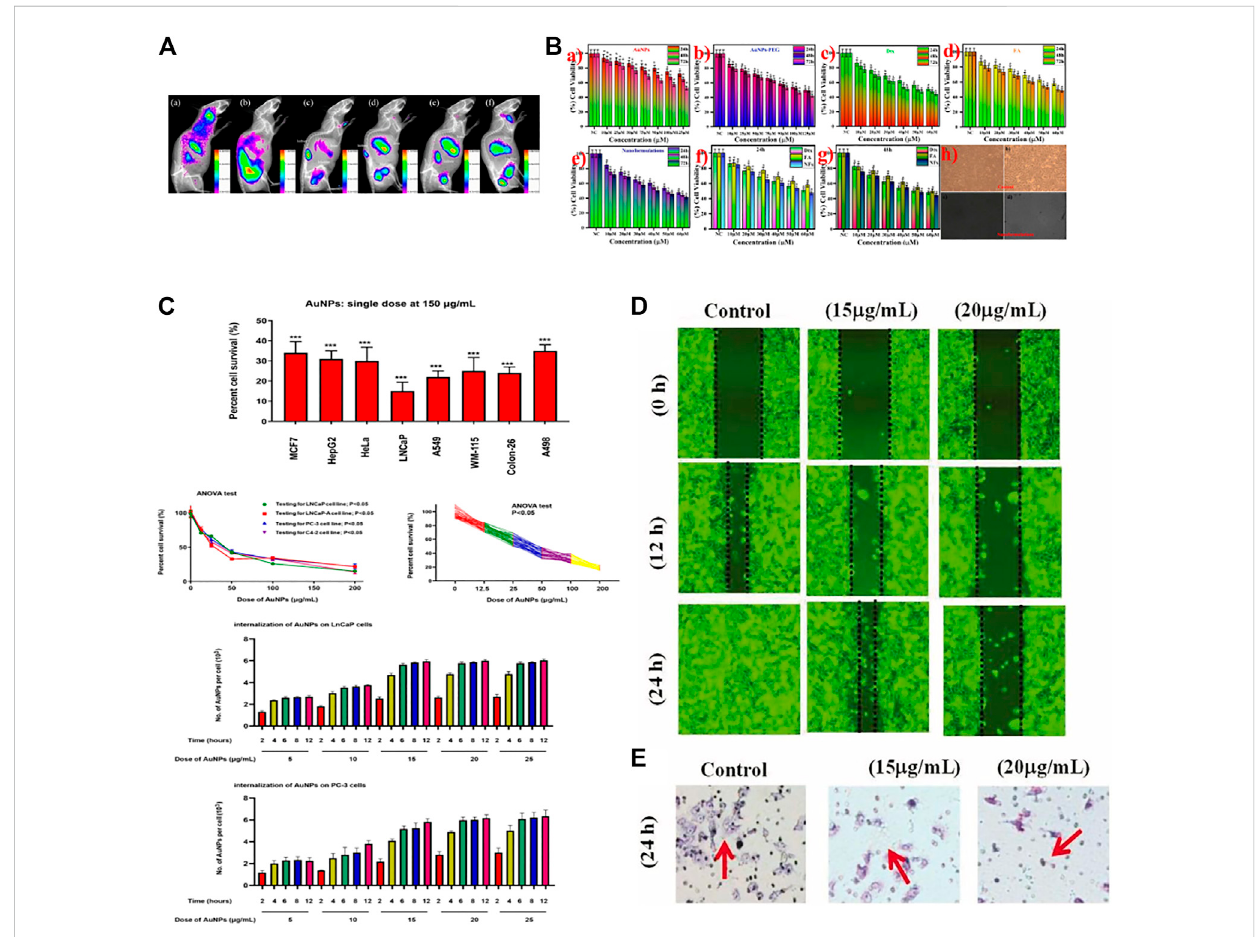
FIGURE 2 Applications of gold nanoparticles (AuNPs) in cancer. (A) PCA cells were treated with ultra fi ne AuNPs containing the gastrin-releasing peptide receptor. After 72 h, up to 6% of the AuNPs remained in the body, which could be used to detect PCa. (B) Docetaxel-coated AuNPs showed toxicity to PCacells invitro . (C) AuNPswerefoundtobetoxictoeighttypesoftumorcells,mostnotablytoPCacells,showingtoxiceffectstoallPCacellstested. (D) AuNPs synthesized from abies fi r plant extracts inhibited bladder cancer T24 cell migration in a concentration-dependent manner. (E) AuNPs mediated T24 cell